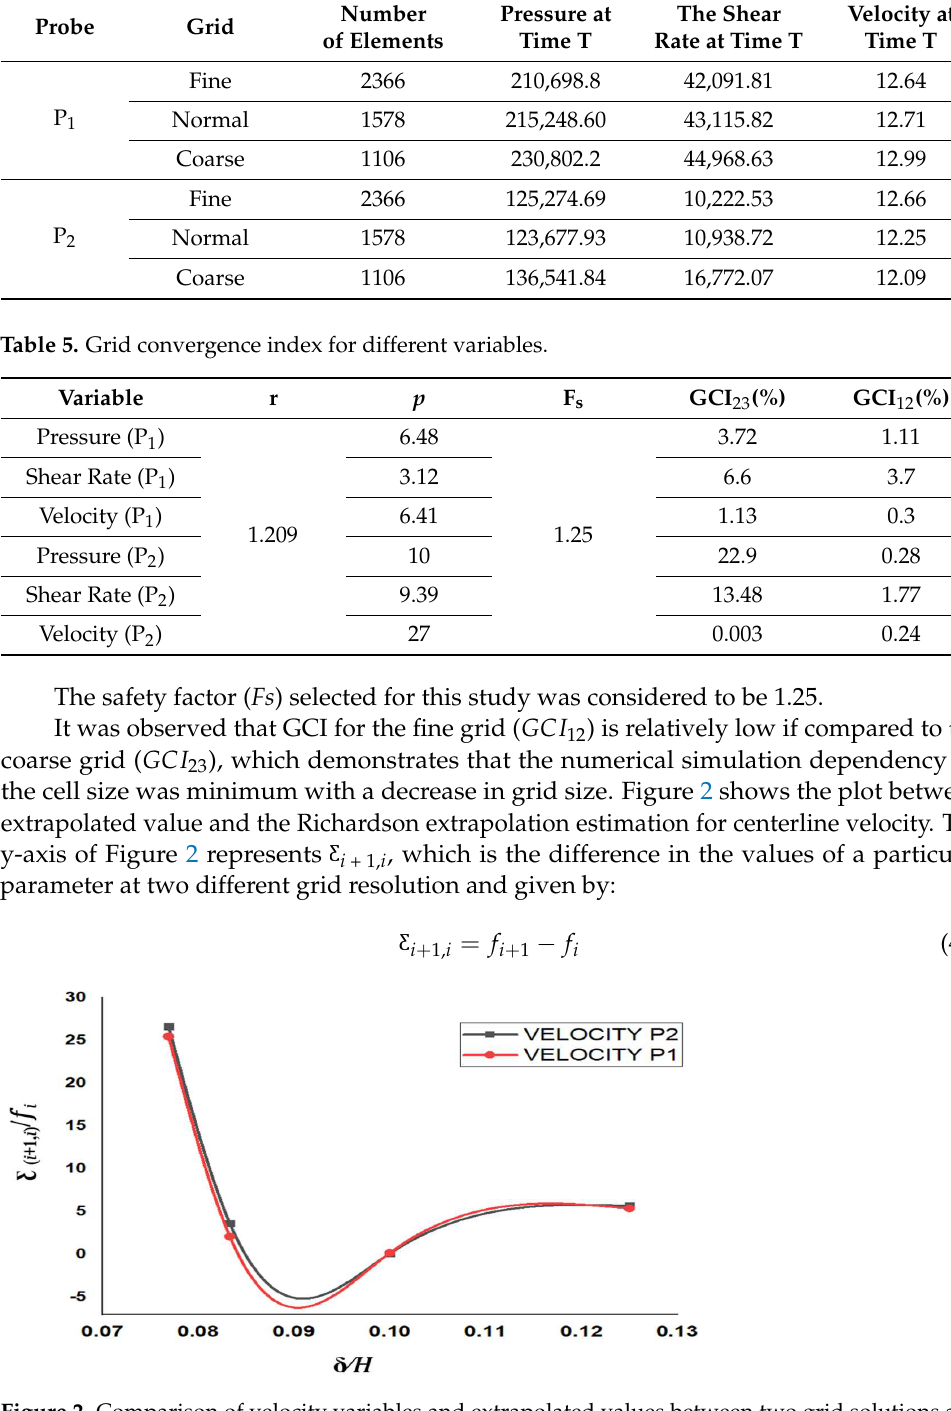
Table 4. Generated data for pressure, shear rate, and velocity from simulation. Number Pressure at The Shear Velocity at Probe Grid of Elements Time T Rate at Time T Time T 2366 Normal element value of Normal discretization